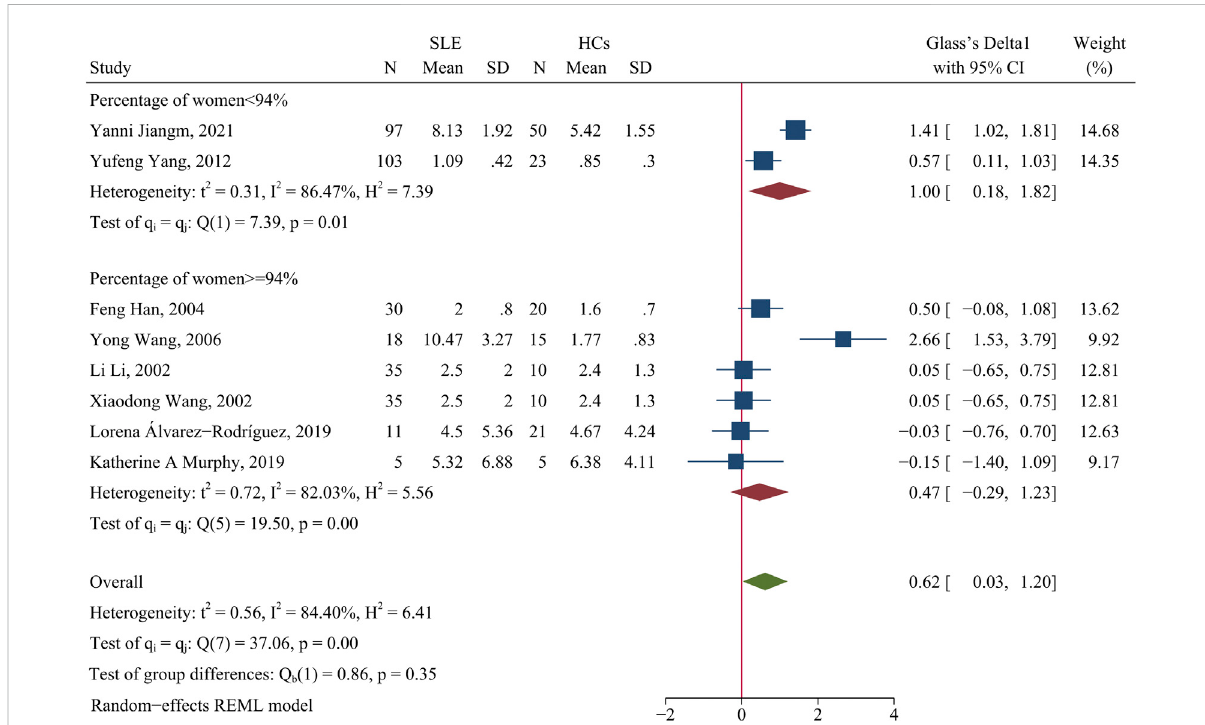
FIGURE 2 Forest plot of the percentage change of Th2 cells in SLE patients compared with HCs. The overall results (bottom) show the meta-analysis of 8 studies, and the other two results show meta-analyses of subgroups according to the percentage of females. SLE, systemic lupus erythematosus; HCs, healthy controls.